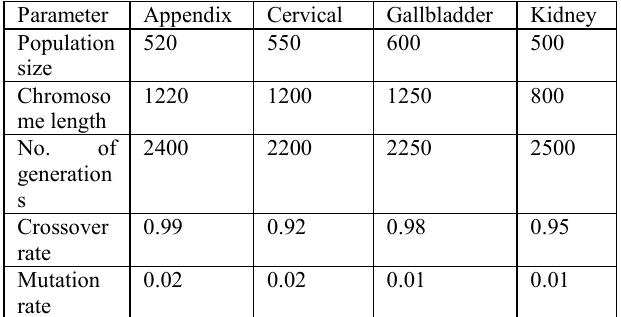
Table 4. Summarized output of proposed technique